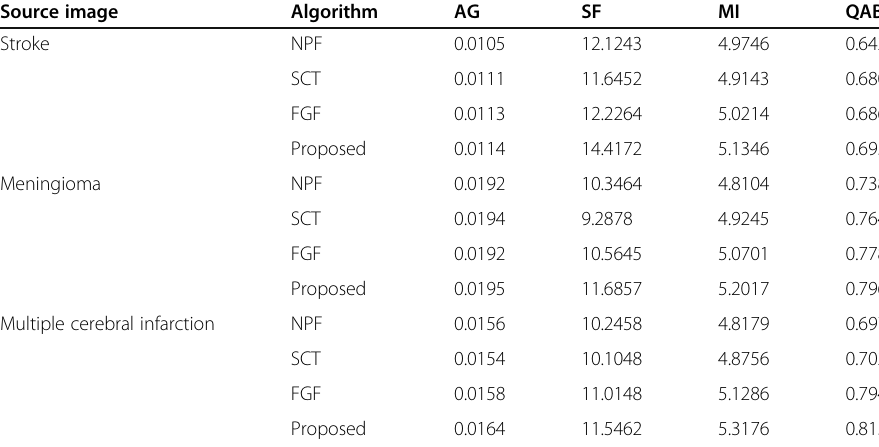
Table 1 Objective indicators of different fusion algorithms Source